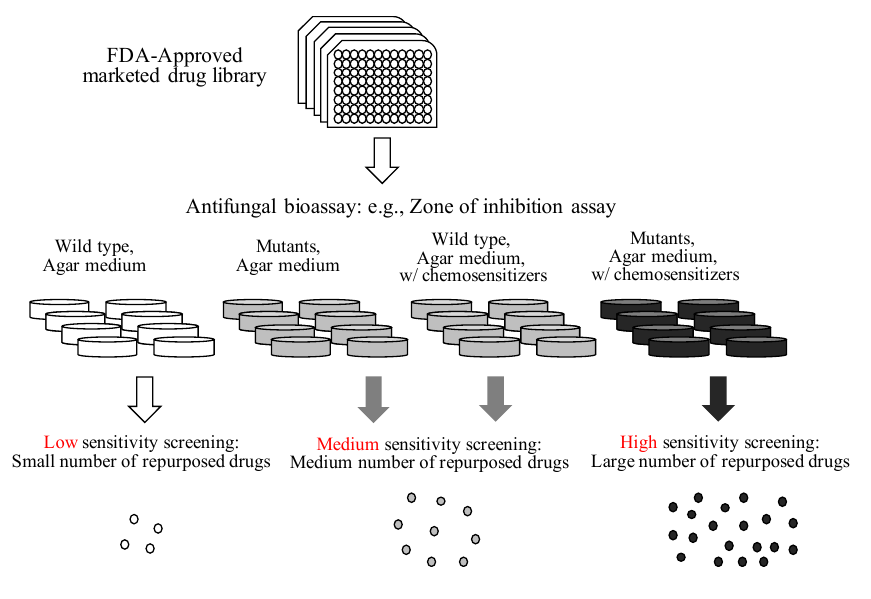
Figure 7. Scheme of high-e ffi ciency drug repurposing